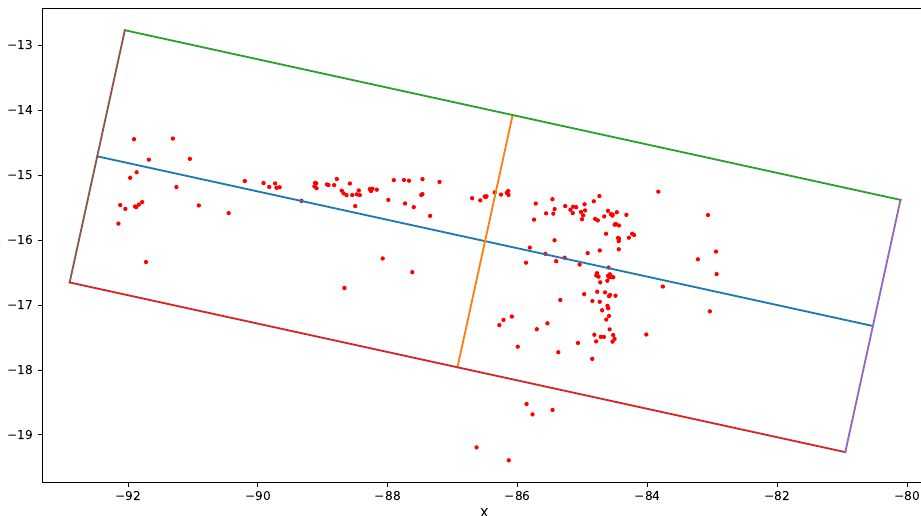
Figure 2. This figure presents example results of objects bounding box calculation using PCA—based approach from Equation (13). Values on the X and Y axis are points coordinates calculated by our algorithm. The scaling of the axes is irrelevant because PCA normalizes variables. Red points are directly calculated from SLAM algorithm. Blue section lays along direction of the highest variance of red points (the first principal component v 1 ). Orange section is perpendicular to blue section and it lies along direction of the second highest variance of red points (the second principal component v 2 ). The bounding box have four edges: violet ( b 4 ), green ( b 3 ), brown ( b 2 ) and red ( b 1